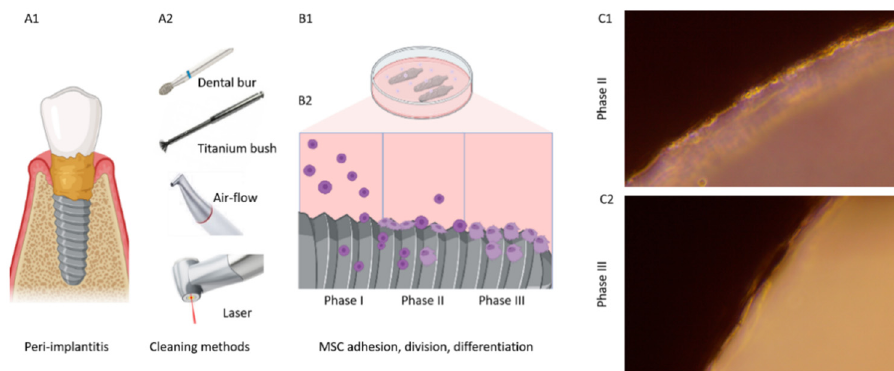
Figure 2. Principal scheme of the experiment: implants isolated from peri-implantitis ( A1 ) were treated with different cleaning methods ( A2 ) and cultured in an MSC-containing hydrogel-based culture medium( B1 ). Mesenchymal stem cells attached to the surface (Phase I, B2 ), divided (Phase II, C1, B2 ), and differentiated (Phase III, C2,B2 ).